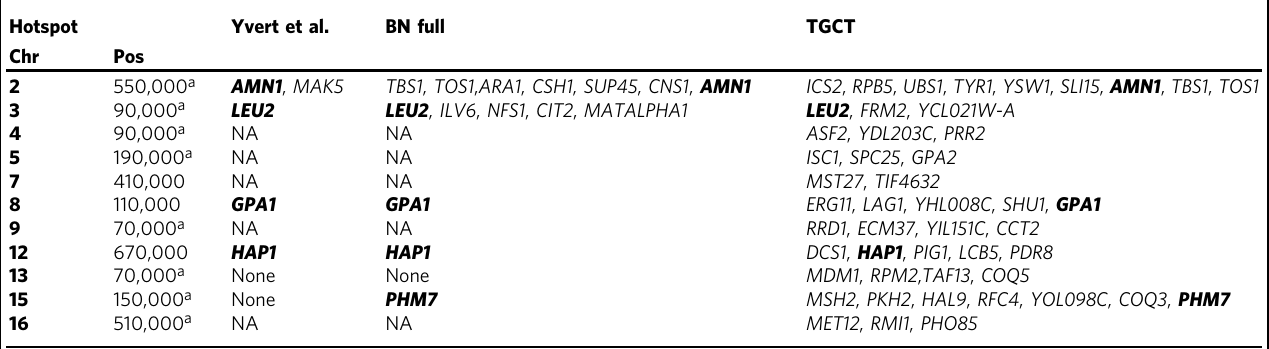
Table 4 Causal regulators for teQTL hotspots inferred by the TCGT test Hotspot